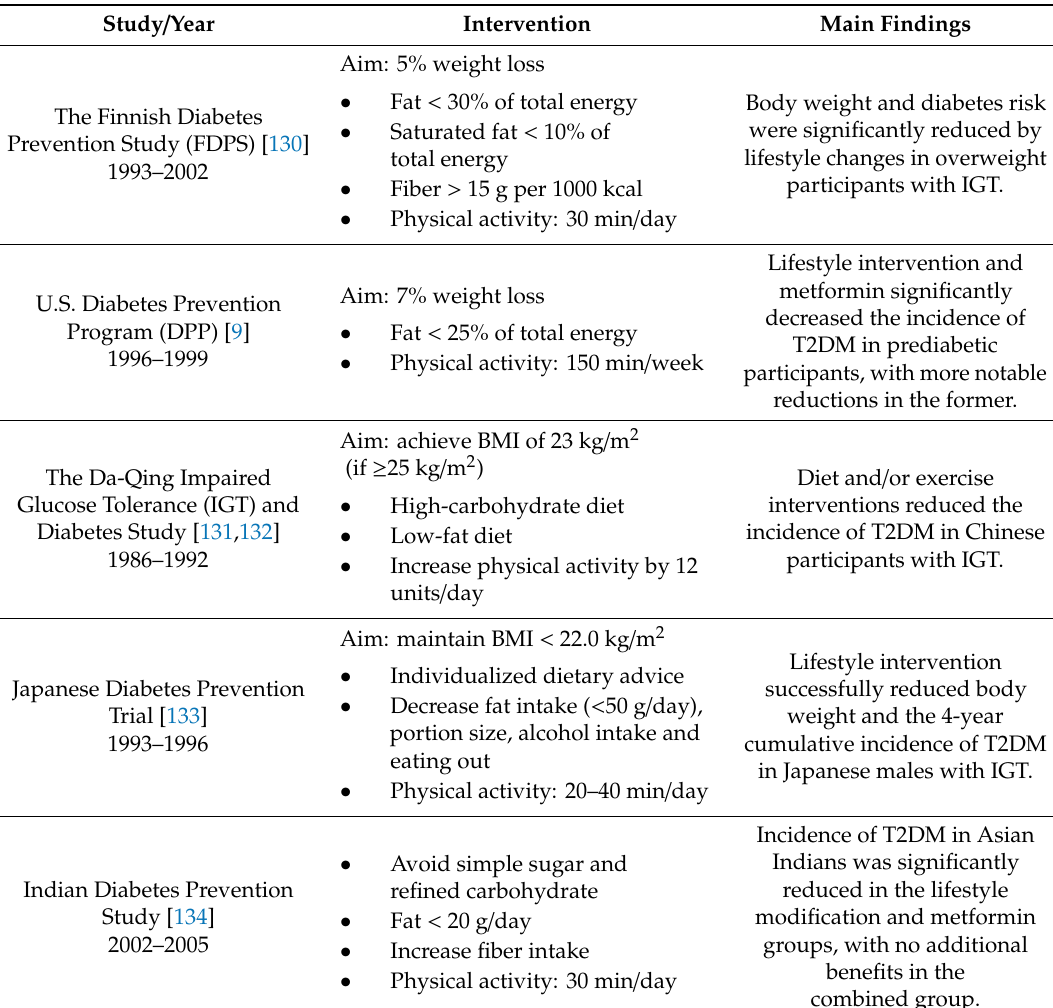
Table 3. Lifestyle modifications in past major type 2 diabetes mellitus (T2DM) prevention